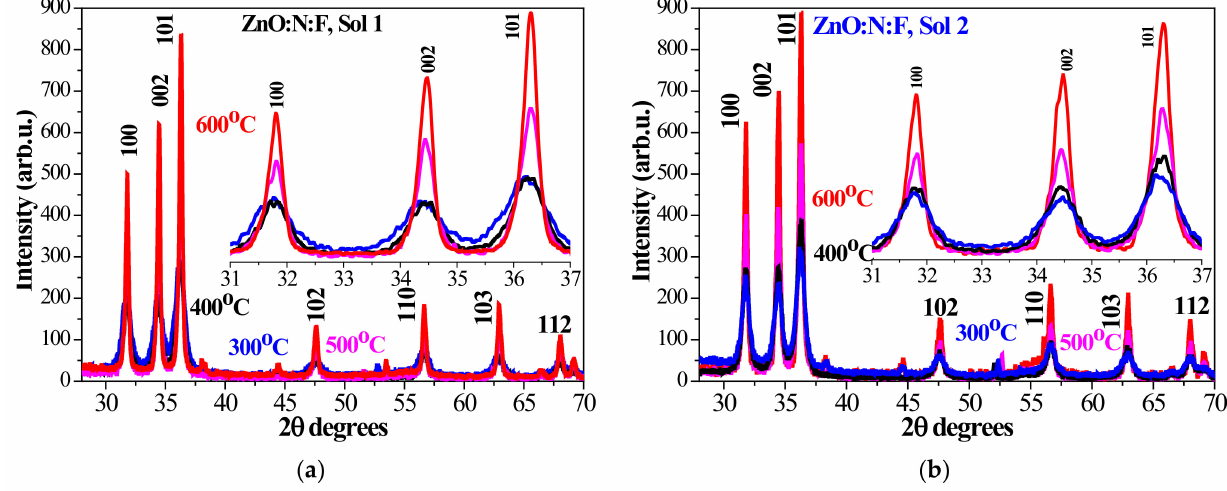
Figure 2. XRD patterns of ( a ) ZnO:N:F films (Sol 1), ( b ) ZnO:N:F films (Sol 2), treated at 300, 400, 500 and 600 ◦ C. The inset figures present the enlarged XRD patterns in 2 θ range = 31–37 ◦